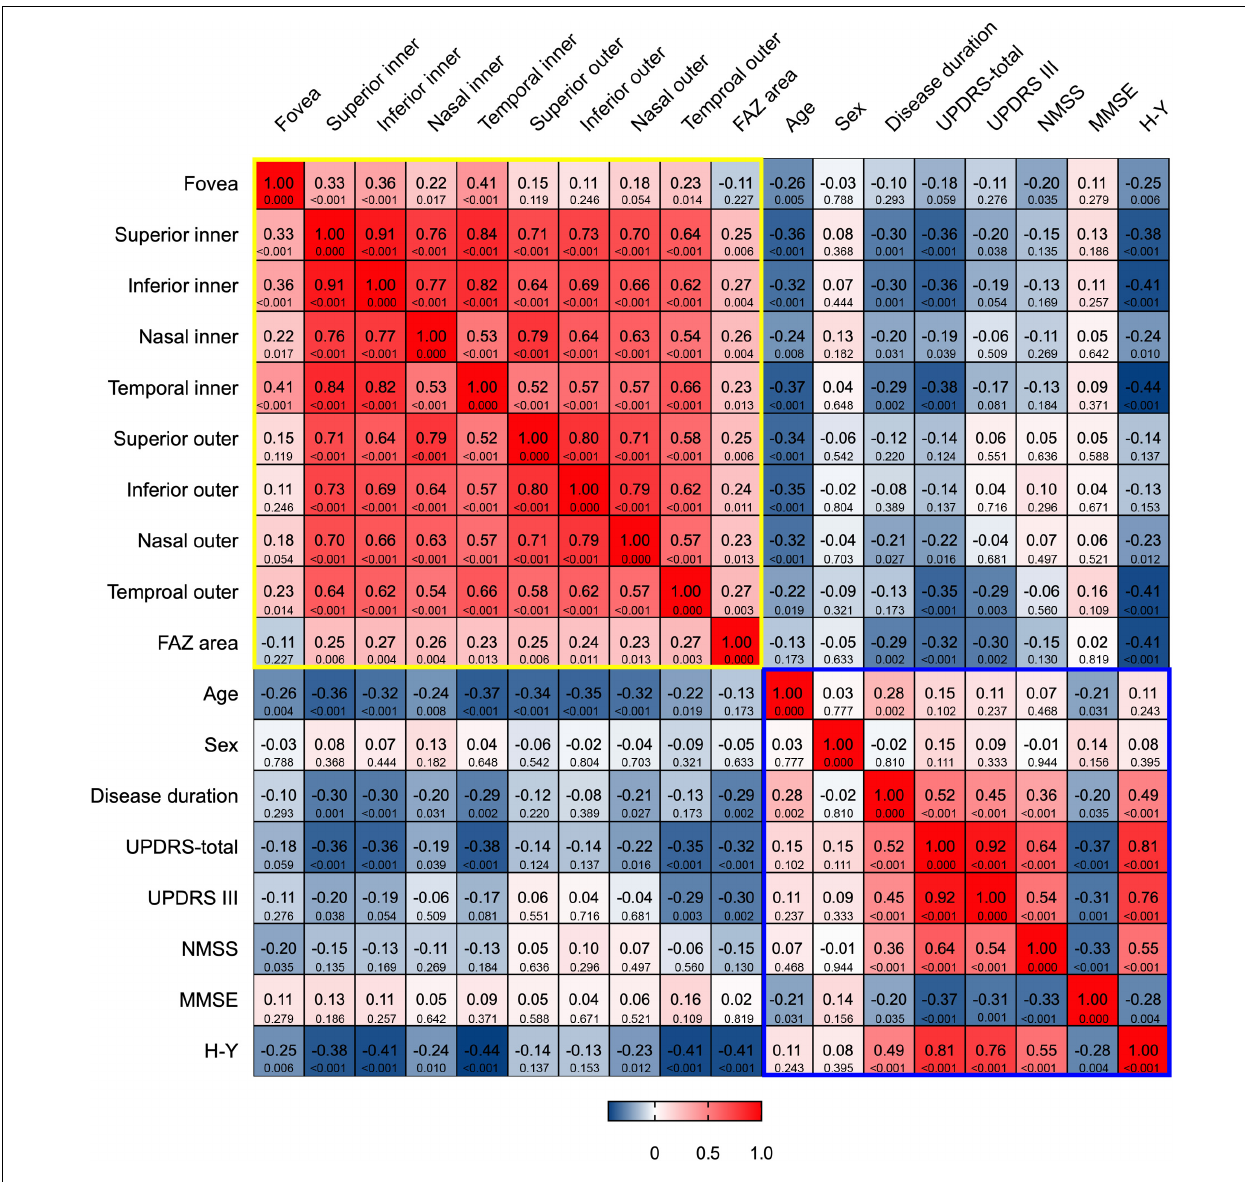
FIGURE 3 | Heat map of correlation between m-VD and clinical parameters. There was a significant negative correlation between all subfields m-VD and age. In addition, there was a negative correlation between the m-VD of some subfields and disease duration, UPDRS-total, UPDRS III, NMSS scores, and H-Y stage. The top row of each cell is the Spearman correlation coefficients, and the bottom row is the corresponding p -value. The yellow and blue box represented the correlations among OCT parameters, and among clinical parameters,